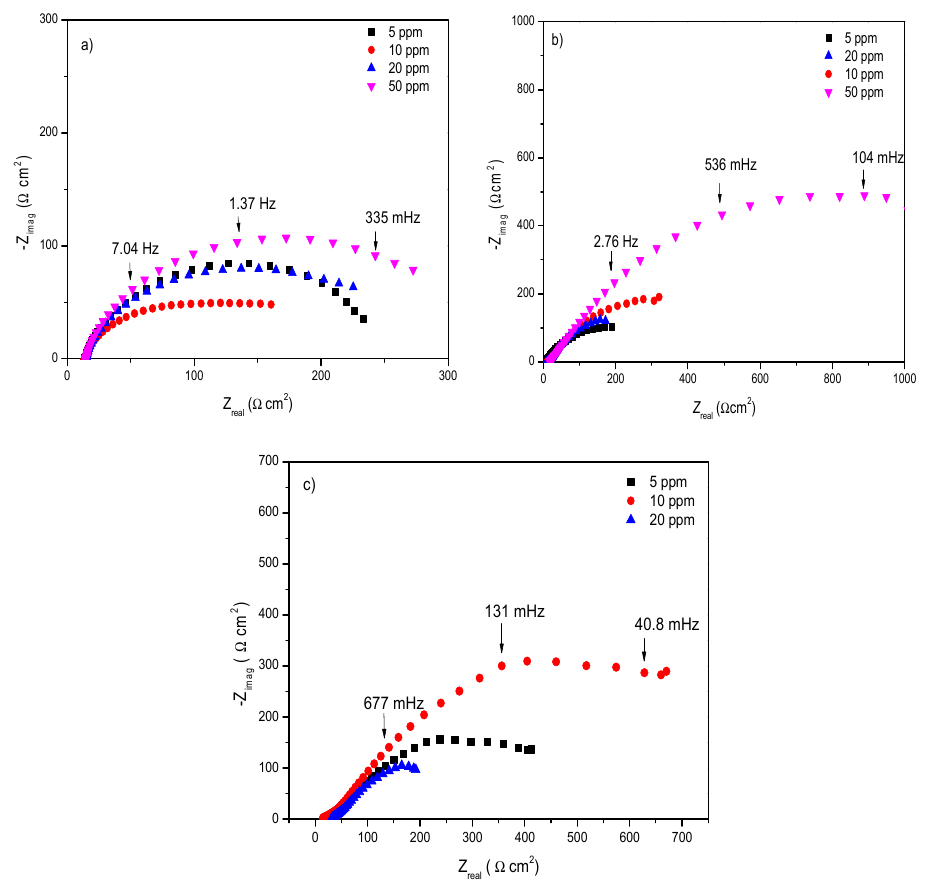
Figure 5. Nyquist diagram of 4-PC in 1018 steel immersed in 3% of NaCl + CO 2 at different rotation rates ( a ) 0 rpm, ( b ) 100 rpm and ( c ) 500 rpm.